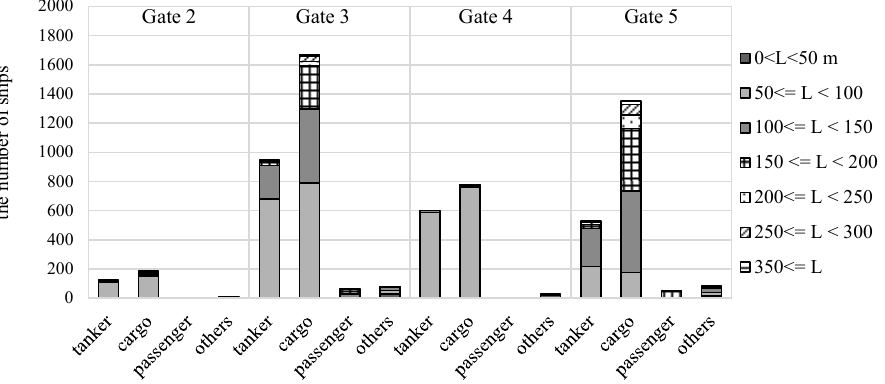
Figure 7. Ship volume and composition of ship length and ship type. The gates are shown in Figure 6.